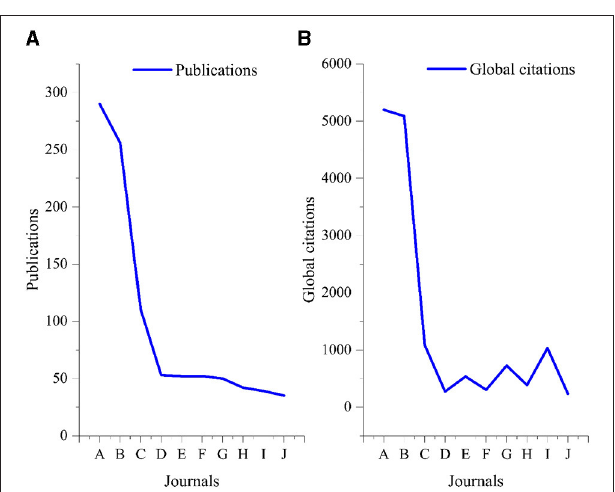
The top three most prolific authors were Upperman JS ( n = 29, citations = 202), Tepas JJ ( n = 27, citations = 721), and Burd RS ( n = 25, citations = 243) as shown in Figure 4 .